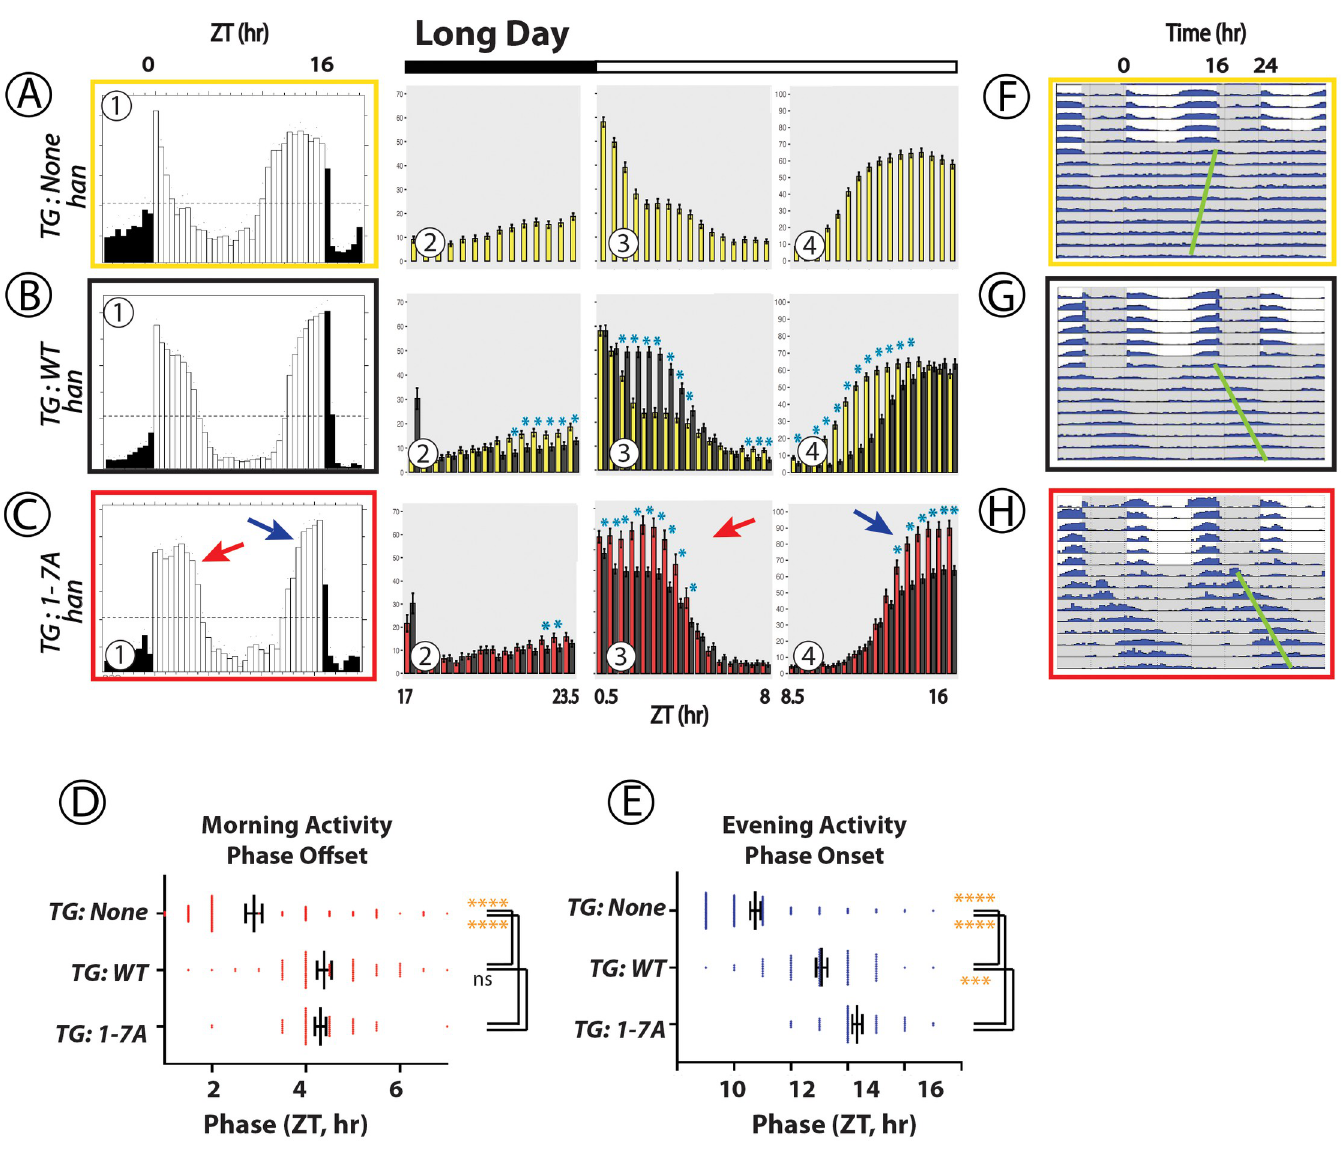
Fig 4. Locomotor Rhythms exhibited by pdfr mutant flies expressing the WT PDFR versus the 1-7A PDFR Variant under Long-day (summer-like) conditions. All behavioral records were recorded from han ( pdfr mutant) flies that expressed either no UAS transgene (A, yellow box), or a UAS-WT pdfr transgene (B, black box) or a UAS-1-7A pdfr (C, red box)). The Panels present behavioral activity with a format similar to the one shown in Fig 2. Panels (A)-(C) display average group eductions (6-day average activity, with open bars indicating the 16-hr periods of Lights-on and filled bars the 8-hr periods of Lights-off) and bin-by-bin analyses to compare activity amplitudes between genotypes. TG : transgene. The red and blue arrows indicate Morning and Evening activity respectively, in flies expressing the 1-7A variant with distinguished amplitude and/or phase. Blue asterisks mark amplitudes that are significantly different between genotypes by ANOVA followed by a Students t-test (p < 0.05). Panels (D) and (E) display the phases of Morning Offsets and Evening Onsets respectively. Gold asterisks: ANOVA followed by Dunnett’s post hoc multiple comparisons of all compared to WT: ns = not significant; � = p < 0.05; �� = p < 0.01; ��� = p < 0.005; ���� = p < 0.001. Panels (F)–(H) display double plotted actograms of activity during the ~6 days of light:dark conditions, followed by activity during ~9 days of DD. The green bars indicate the phase of the dominant activity period in